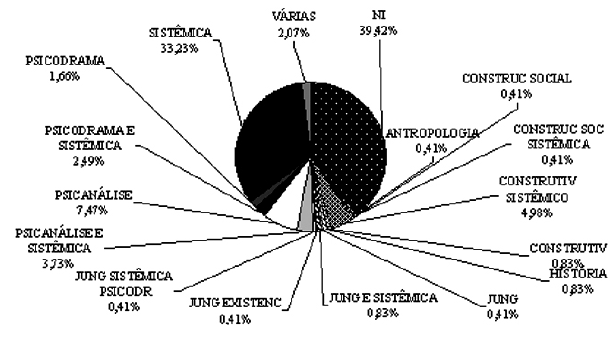
Figura 5 . Referências teóricas apresentadas no Caderno de Resumos do I Congresso Brasileiro de Terapia de Família.